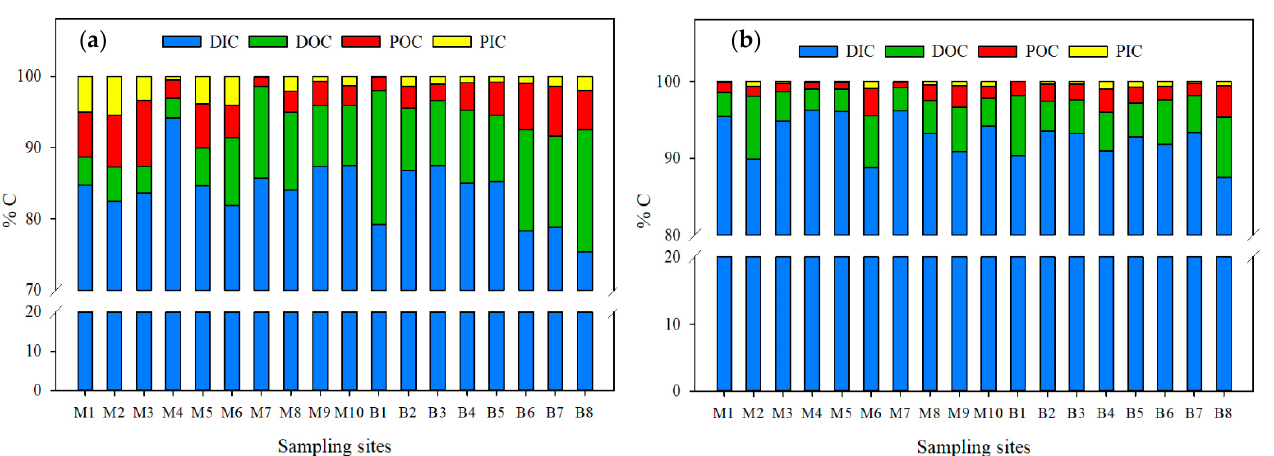
Figure 6. ( a ) Longitudinal variations in the DIC and ( b ) PIC concentrations (±SD) according to the distance to the Usumacinta River’s mouth during the rainy (RS) and dry (DS) seasons. The mainstem differs in both seasons from the tributaries.